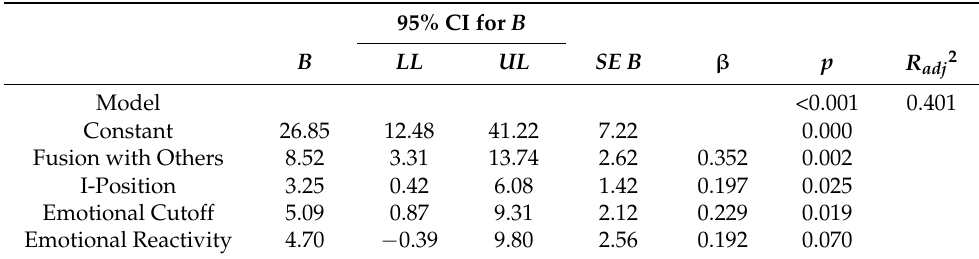
Table 6. Differentiation of self-inventory-short form as a predictor for psychological adjustment to separation test lonely negativity